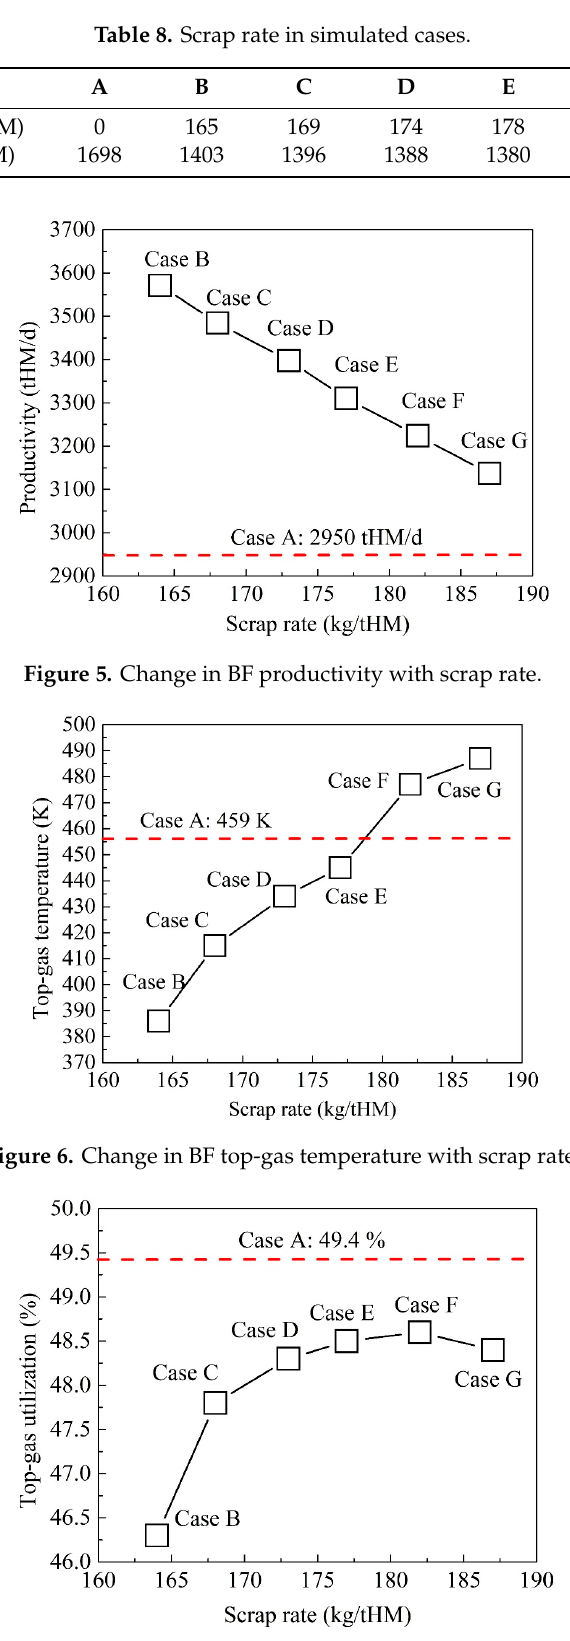
Figure 7. Change in BF top-gas utilization with scrap rate.